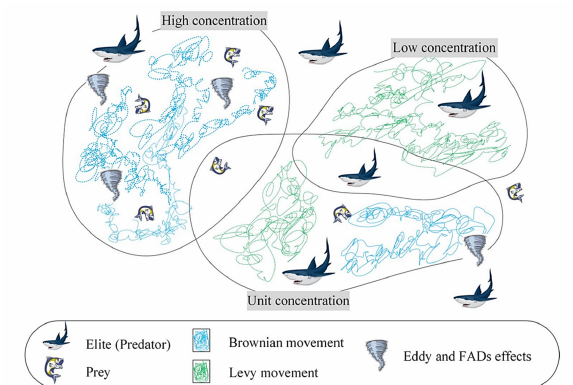
Fig. 3. Process of three-stage foraging